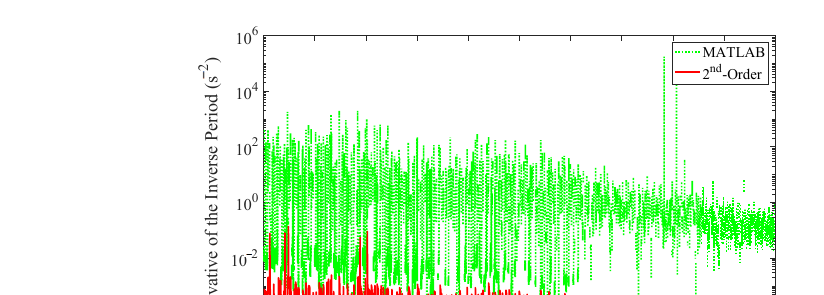
Figure 4. Estimations of reactor period and total reactivity given by different differentiators: ( a ) reactor period, ( b ) reactivity.